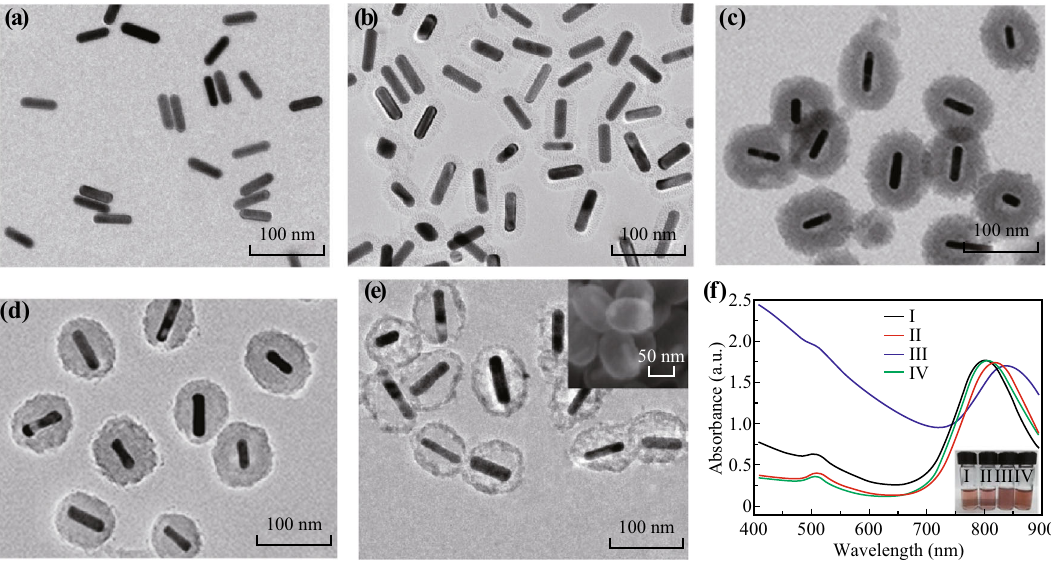
Fig. 1 TEM images of a AuNRs, b AuNR@mSiO 2 core–shell NPs, c AuNR@mSiO 2 @PAA-Ca core–shell NPs, d AuNR@mSiO 2 @PAA/CaP core–shell NPs, e AuNR@PAA/CaP yolk–shell NPs, the inset shows the SEM image of the yolk–shell NPs, f UV–Vis absorbance spectra of (I) AuNRs, (II) AuNR@mSiO 2 core–shell NPs, (III) AuNR@mSiO 2 @PAA/CaP core–shell NPs and (IV) AuNR@PAA/CaP yolk–shell